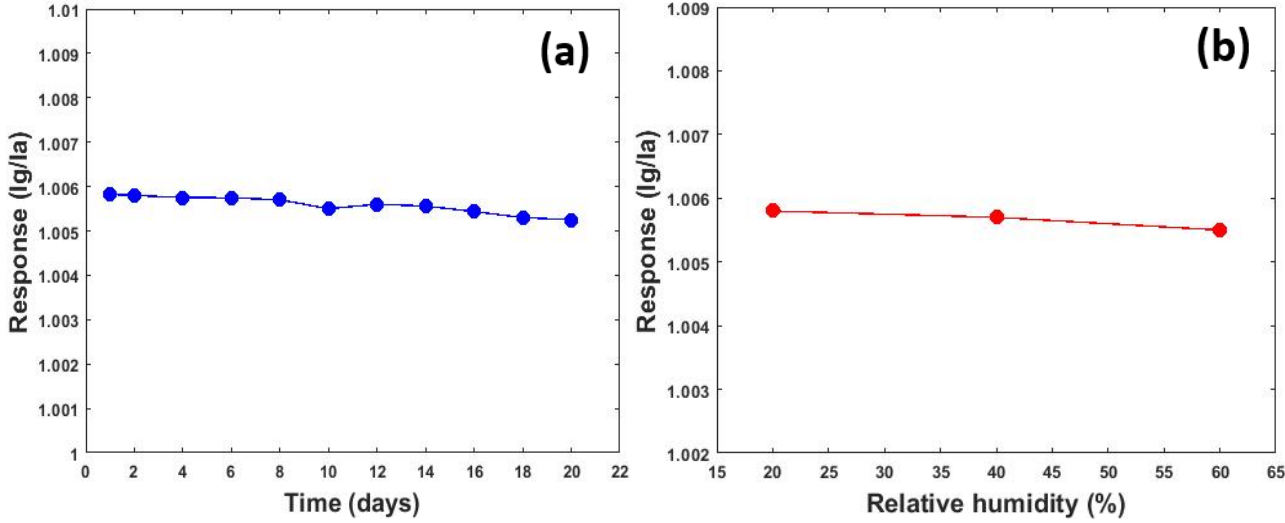
Figure 13. ( a ) Long-term stability of ZnO microfluidic-based gas sensor. ( b ) The effect of humidity on sensing response.